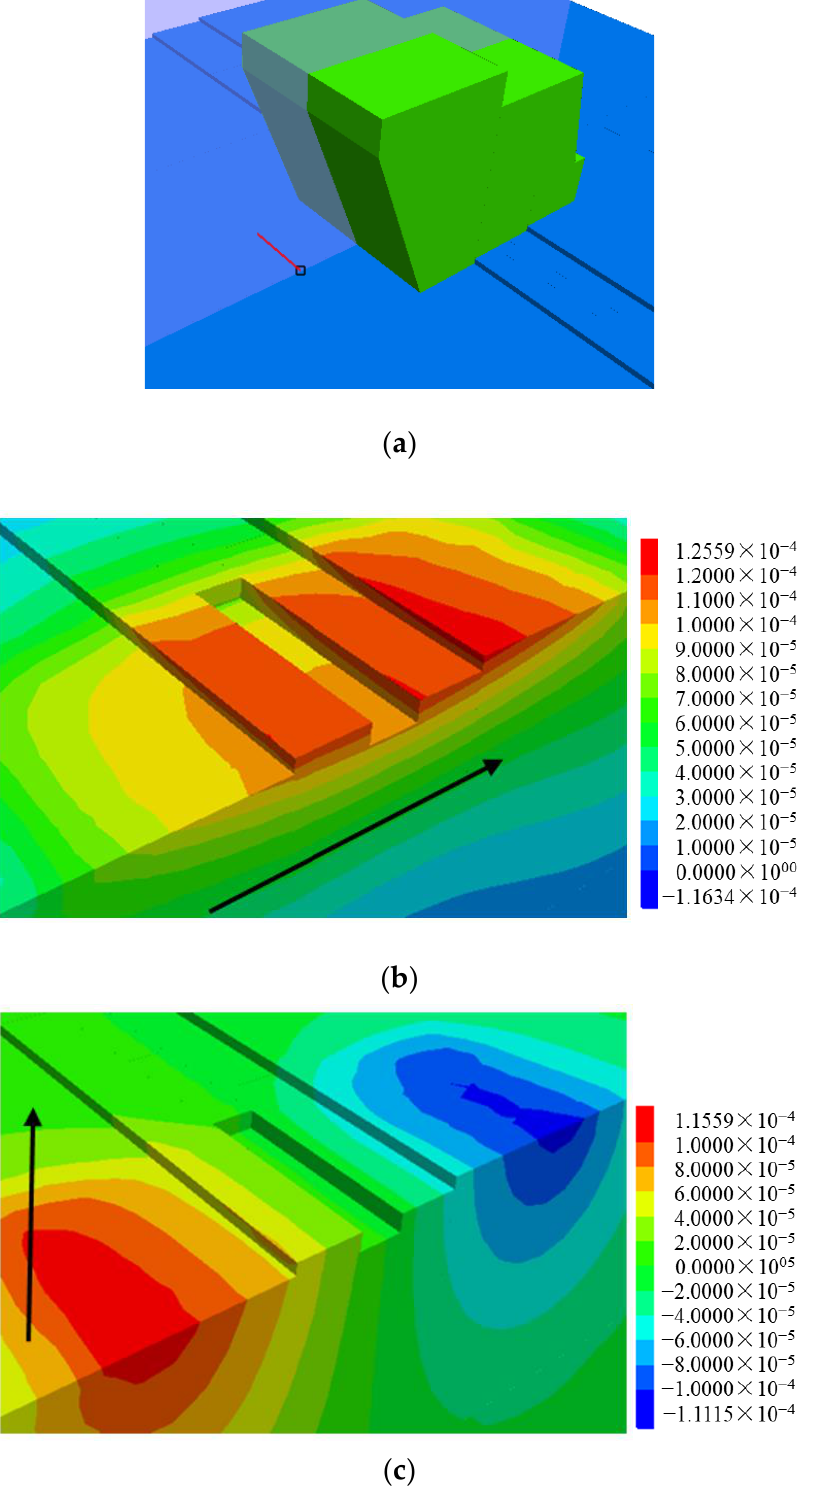
Figure 11. The displacement of the rock mass foundation. (Unit in m). ( a ) The orientation of the section; ( b ) Section view of the horizontal displacement of the rock mass foundation; ( c ) Section view of the vertical displacement of the rock mass foundation.